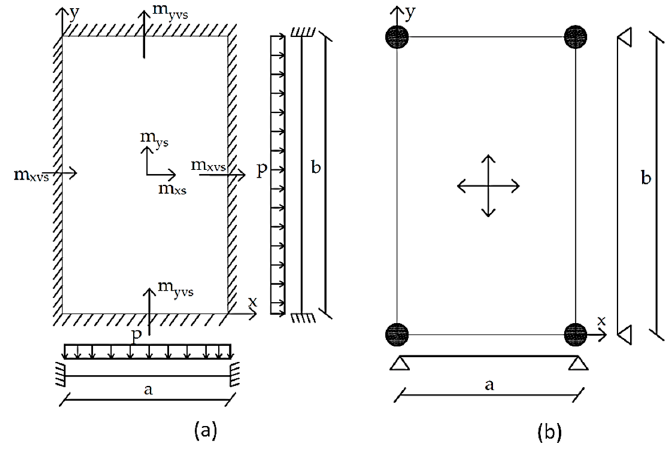
Figure 8. ( a ) Fixed-ended slab and ( b ) flat slab.